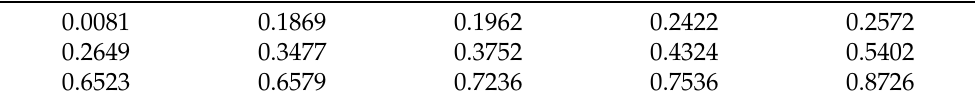
Table 2. The numerical sequential order statistic (SOS) sample from mixture-BXIID for β = 5, δ 1 = 5, δ 2 = 10, p = 0.7, and θ = 1.02 when n = 30 and r = 15.